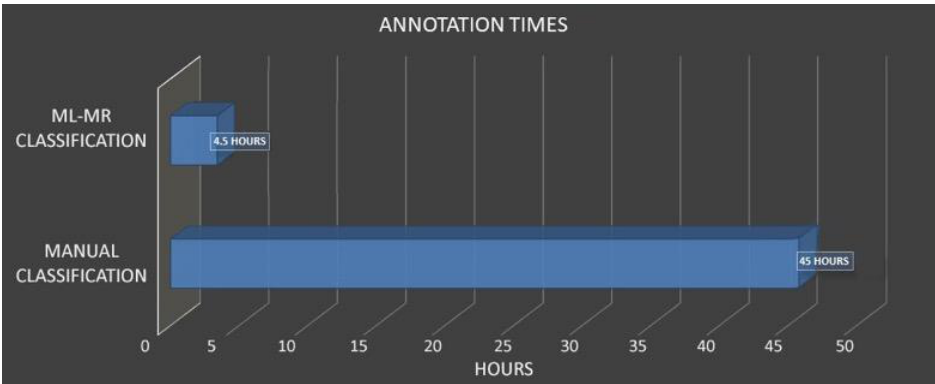
Figure 21. Timing comparison between the manual and ML-MR approaches.